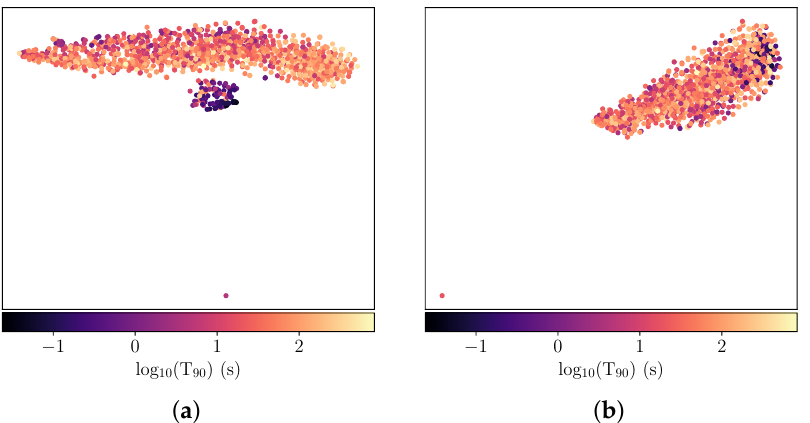
Figure 8. 2D t-SNE representation of the wavelet feature extraction applied to Swift /BAT light curves covering time intervals ( a ) T 0 1s to T 0 + 1s and ( b ) T 0 + 1s to T 0 + 2s. The plots are coloured by − burst duration T 90